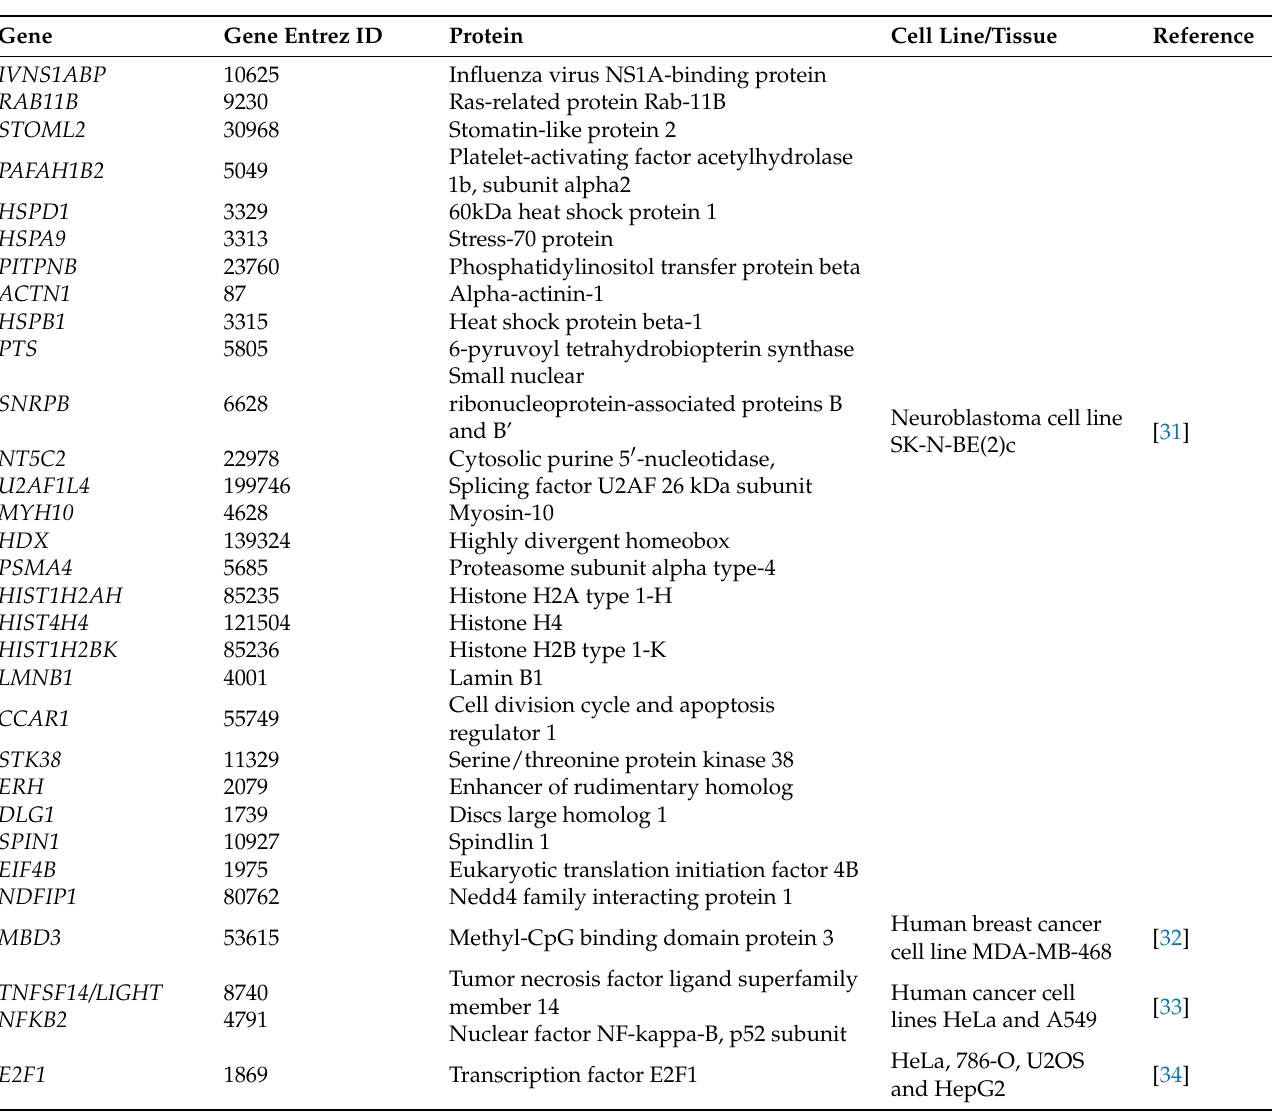
transcription factor, with a putative role in the negative regulation of EPAS1 expression [31]. High expression of EPAS1 was associated with the progression of other types of cancer. Cui et al. (2016) showed that the protein methyl-CpG binding protein 3 (MBD3) binds to the EPAS1 promoter in breast cancer cells and contributes to enhanced EPAS1 transcription. MBD3 binds to the CpG-rich promoters and induces demethylation of promoters and active EPAS1 gene expression [32]. D’Ignazio et al. (2018) found another inducer of the EPAS1 expression in cancer cells, tumor necrosis factor superfamily member 14 (TNFSF14), also known as LIGHT. LIGHT-induced expression of EPAS1 requires binding of p52 protein to the EPAS1 promoter [33]. Transcription factor E2F1 was also proved to regulate EPAS1 transcription [34] (Table 1). Table 1. List of obtained EPAS1 -specific promoter-associated proteins from different studies and cell lines. Gene Gene Entrez ID Protein Cell Line/Tissue Reference